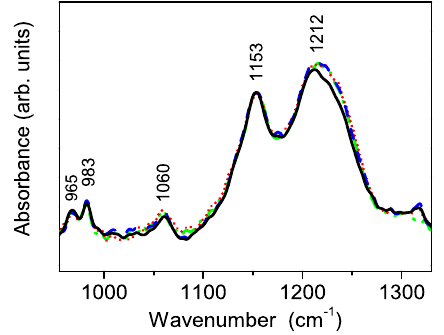
Figure10. FT-IR ATR spectra of the pure Nafion (black line) and loaded composite n -TiO 2 -S-N (n = 2, 5, 7 ) membranes showing small, but significant, differences in the spectral region near 1220 cm − 1 . For the details refer to the text.